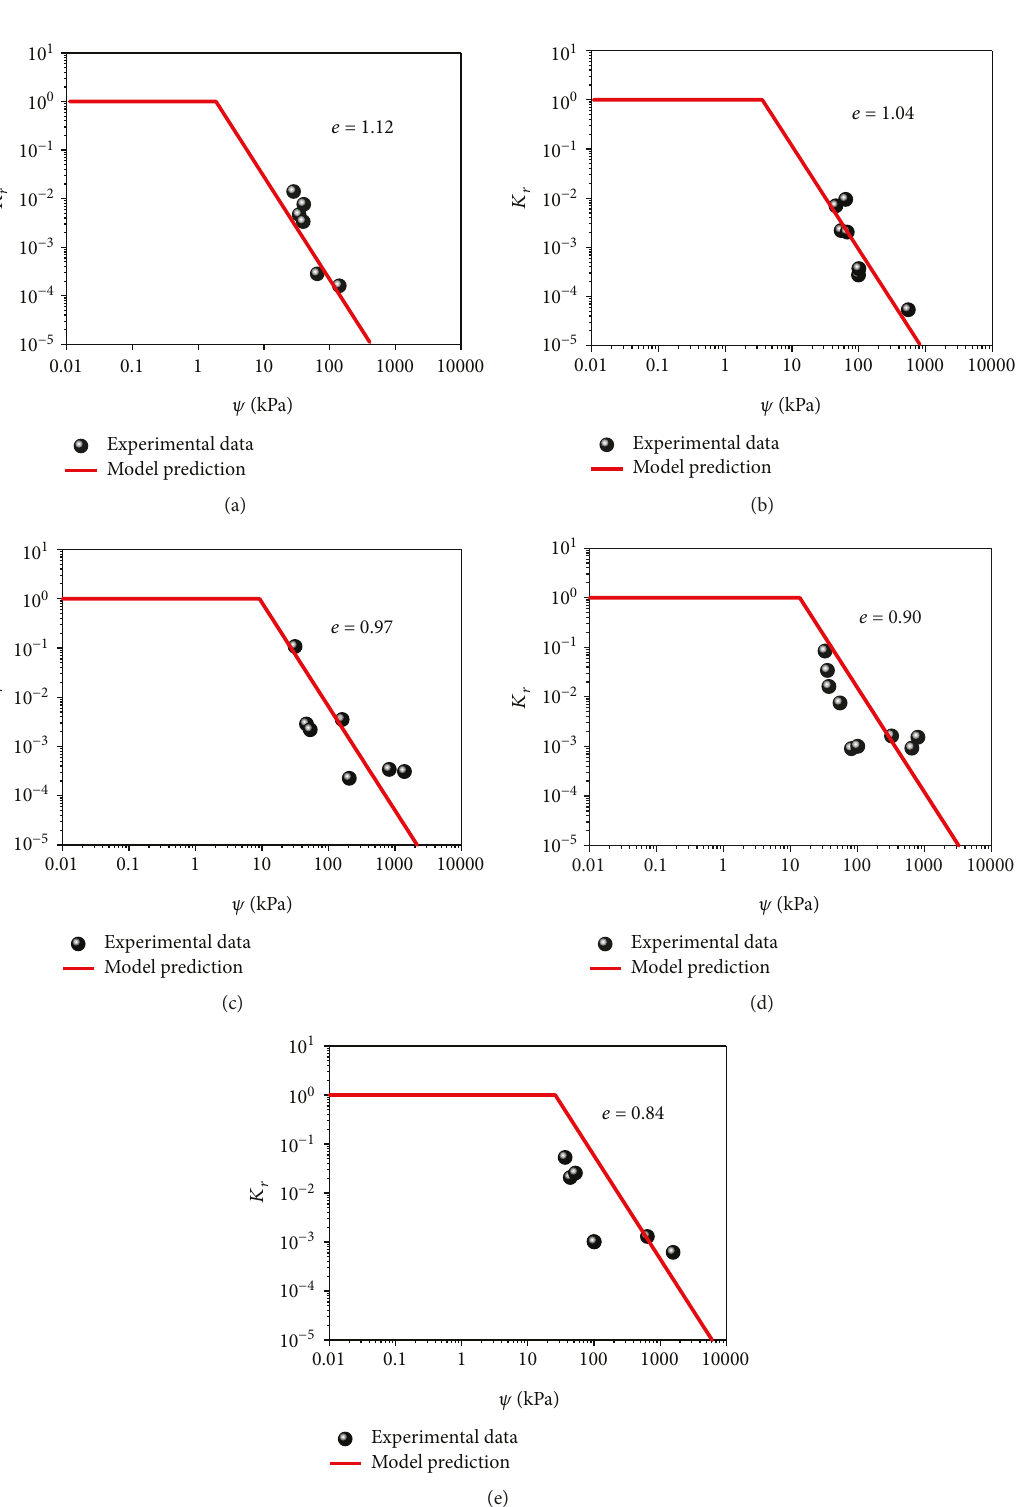
Figure 7: Comparison between predicted values and experimental results of the relative hydraulic conductivity of deformable Hunan